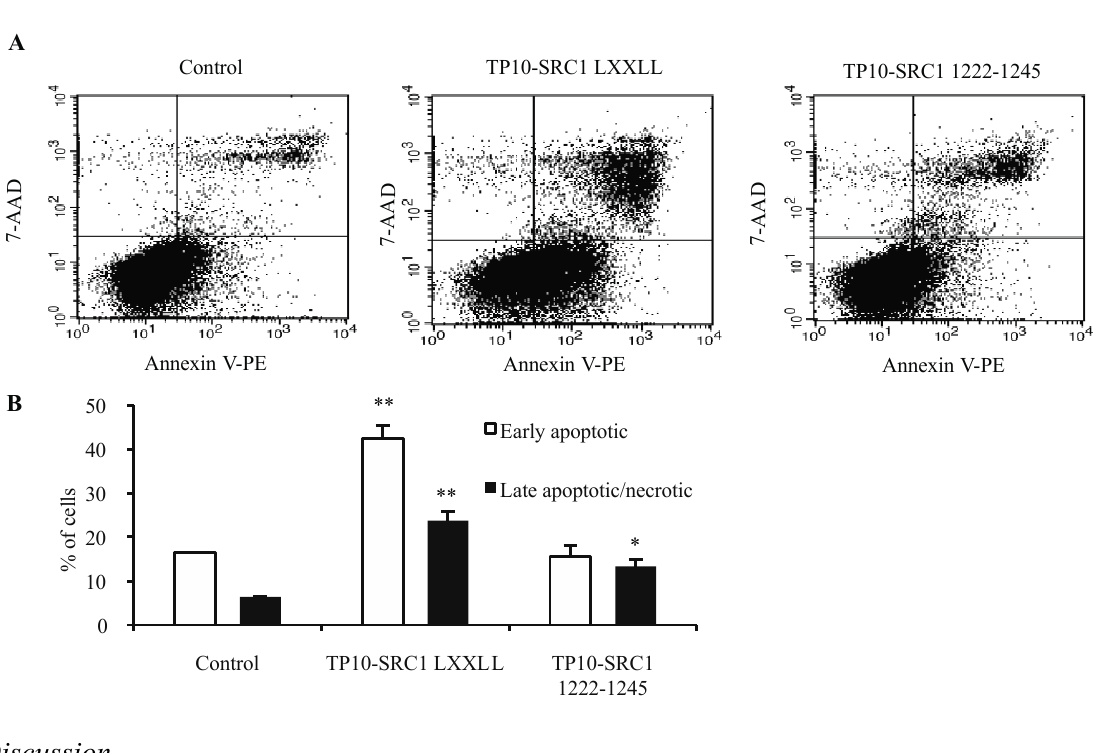
, LXXLL , sequence of 1222–1245